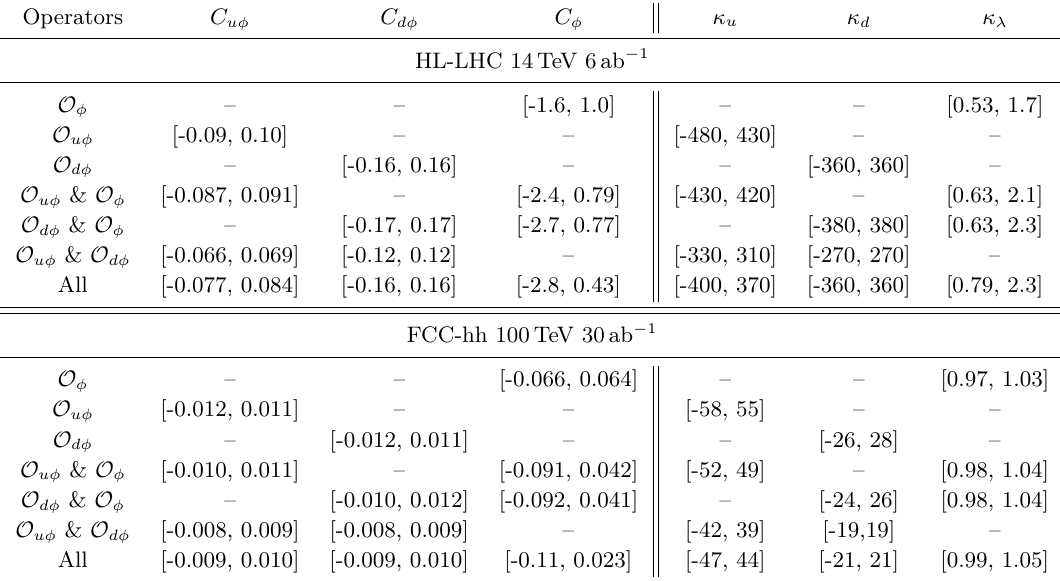
Table 5 . The 1 σ bounds on C uφ , C dφ and C φ from one-, two- and three-parameter fits for HL-LHC with 6 ab − 1 of data and FCC-hh with 30 ab − 1 of data. The corresponding bounds on the rescaling of the effective couplings, κ , κ and κ are presented on the right side of the u d λ